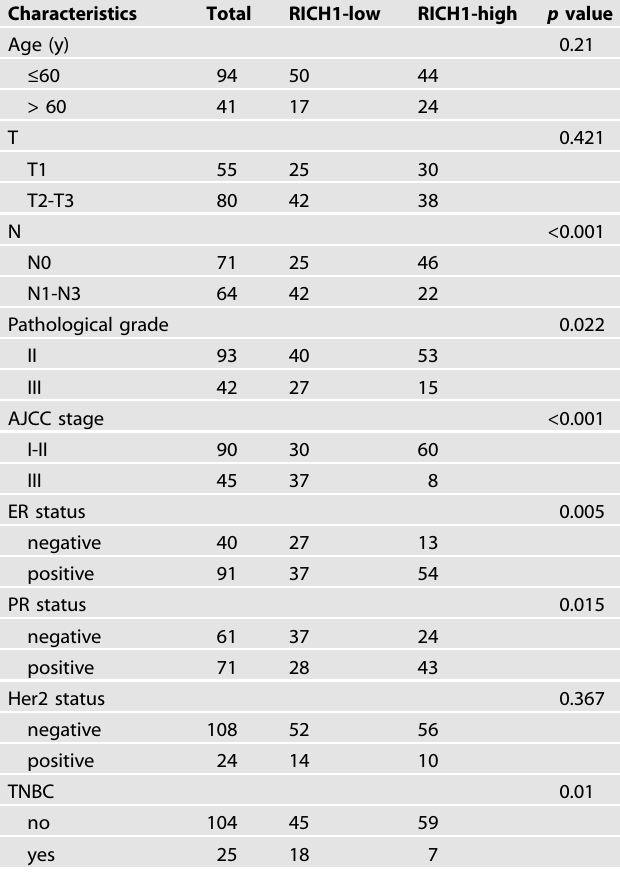
Table 1. Correlation analysis of RICH1 expression levels and clinicopathological parameters in breast cancer